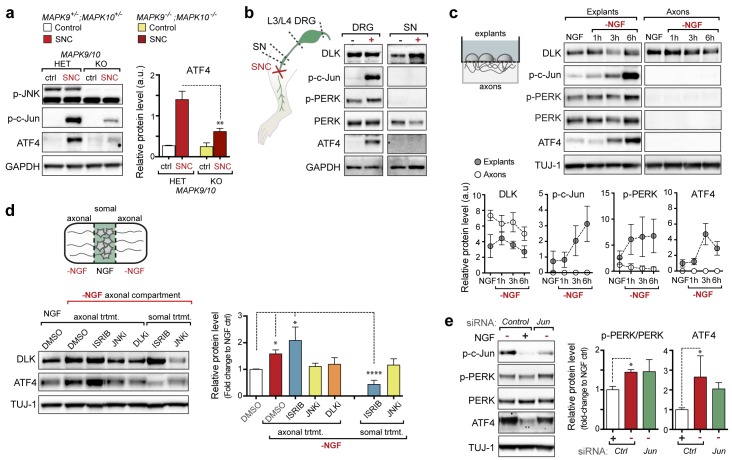
PERK activation is dependent on JNK-mediated retrograde signaling but not c-Jun.(a) Immunoblot of JNK2/3-deficient (Mapk9−/−Mapk10−/−, Mapk9/10 KO) L3/L4 DRGs 24 h after SNC demonstrates reduced ATF4 induction compared to double heterozygous controls (Mapk9+/− Mapk10+/−, Mapk9/10 HET) (n = 3/condition). (b) Immunoblots of L3/L4 DRGs and 5-mm sciatic nerve (SN) segments 2–3 mm proximal to the injury site at 20 h post-SNC (+) illustrate elevation of DLK within the nerve and associated DRGs compared to uninjured DRGs and SN. PERK signaling is not detected within the SN after injury, in contrast to the associated L3/L4 DRGs. (c) Illustration of experimental setup for the isolation of DRG axons from explants (left, see methods). Immunoblots of DRG explants and enriched axons following NGF deprivation at the indicated time points. Phosphorylation of PERK and induction of ATF4 and p-c-Jun is observed in explant (grey), but not axonal (white), lysates quantified by immunoblotting (n = 5/condition, two experiments). (d) Schematic of compartmentalized Campenot chamber setup (top, see methods) displaying isolated axons in the outer compartment and cell bodies/proximal axons in the central compartment. Immunoblots of central compartment lysates after axonal NGF deprivation display elevated ATF4 levels. JNKi and DLKi prevent ATF4 induction when applied to either the central somal compartment or outer axonal compartments, whereas ISRIB only reduces ATF4 upregulation when applied to the central compartment (n = 6–9/condition, five independent experiments). (e) Immunoblots of siRNA-transfected embryonic DRG neurons suggests that c-Jun does not contribute to PERK activation following NGF withdrawal (n = 4–5/condition, three experiments). One-way ANOVA with Bonferroni’s post-hoc test was used for statistical analysis. Data are mean ± SEM. *p<0.05, **p<0.01, ****p<0.0001.